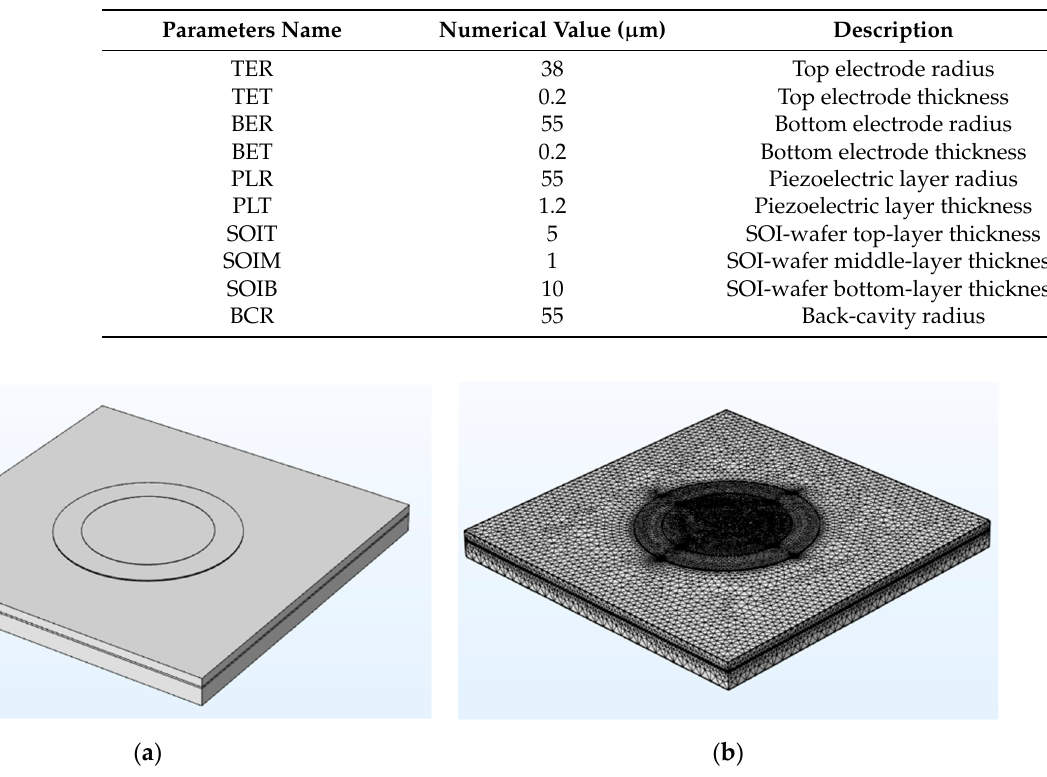
Table 1. The geometric parameters of the PMUT model.